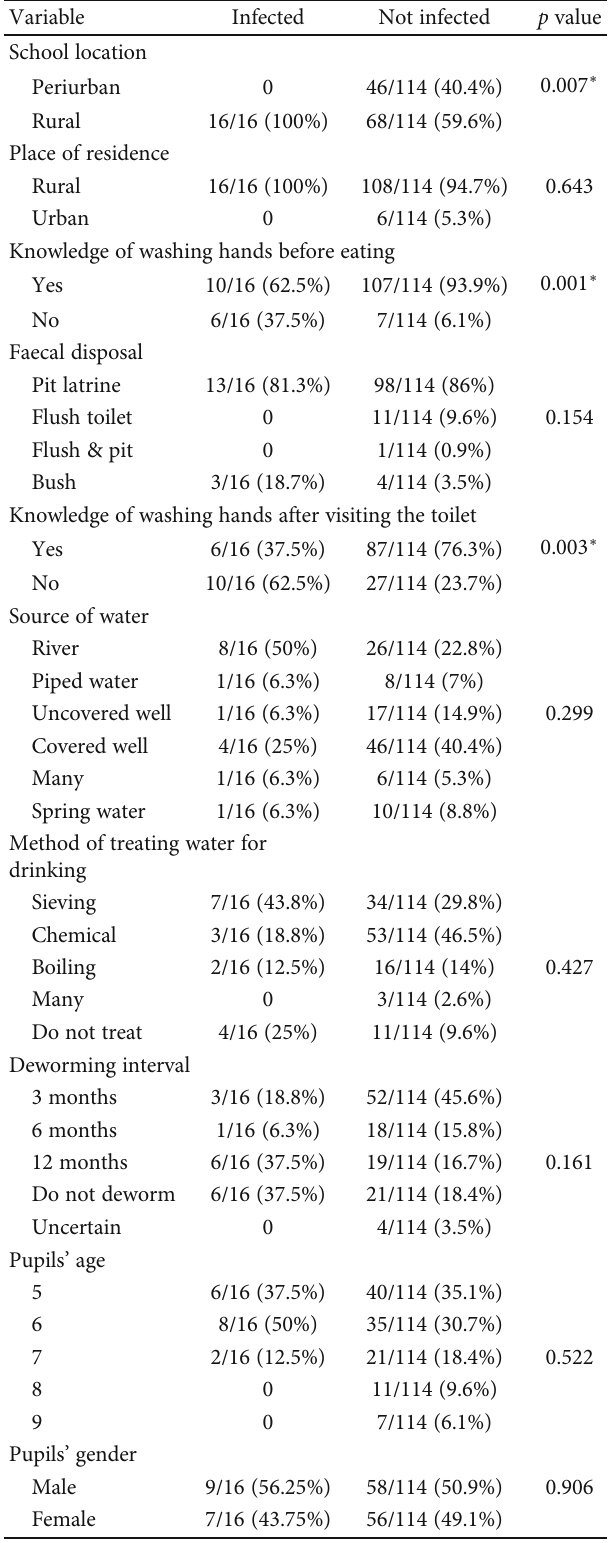
Table 5: Association between intensity and risk